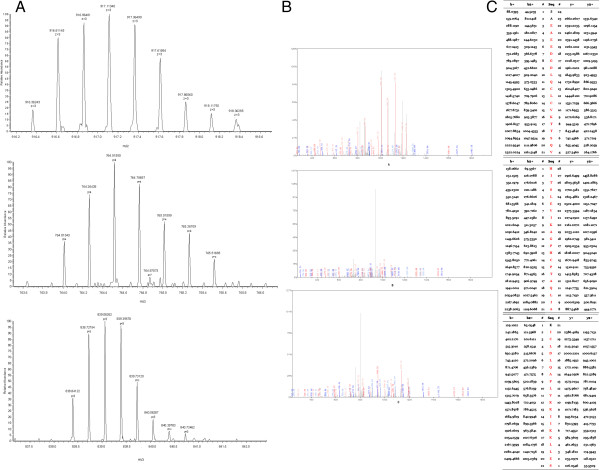
MS/MS map of peptide with MW of 7762.87 Da. (A) The enlarged picture of peptide with MW of 7762.87 Da. (B) The b and y ions spectra used to identify the peptide with MW of 7762.87 Da. (C) The sequence of the peptide with MW of 7762.87 Da.